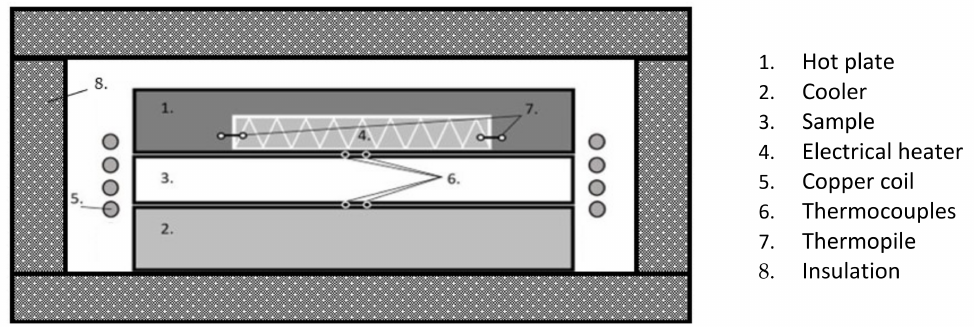
Figure 5. Scheme of a GHP apparatus